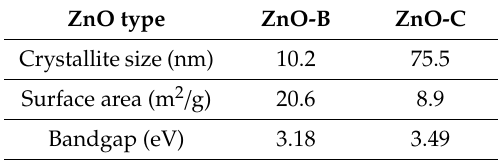
Table 2. Crystallite sizes measured by the Scherrer equation and surface areas measured by the BET.